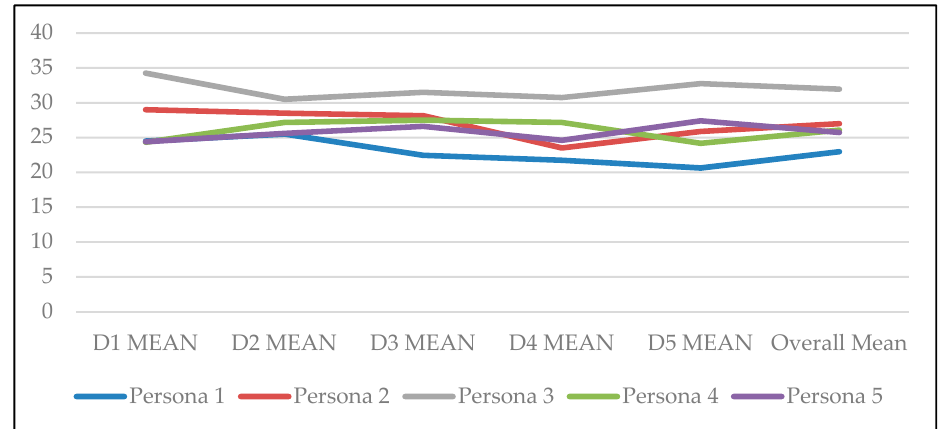
Figure 3. Temporal stability of behavioural archetypes.